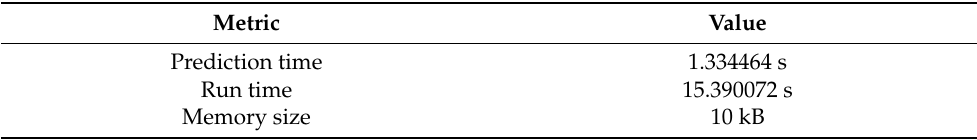
Table 7. Other metrics recorded (multinomial classification) for the NB-based anomaly detector.